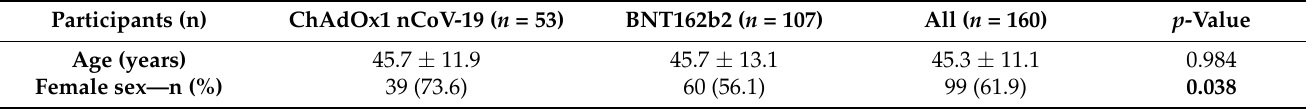
Table 1. Demographic characteristics of the vaccinated group.